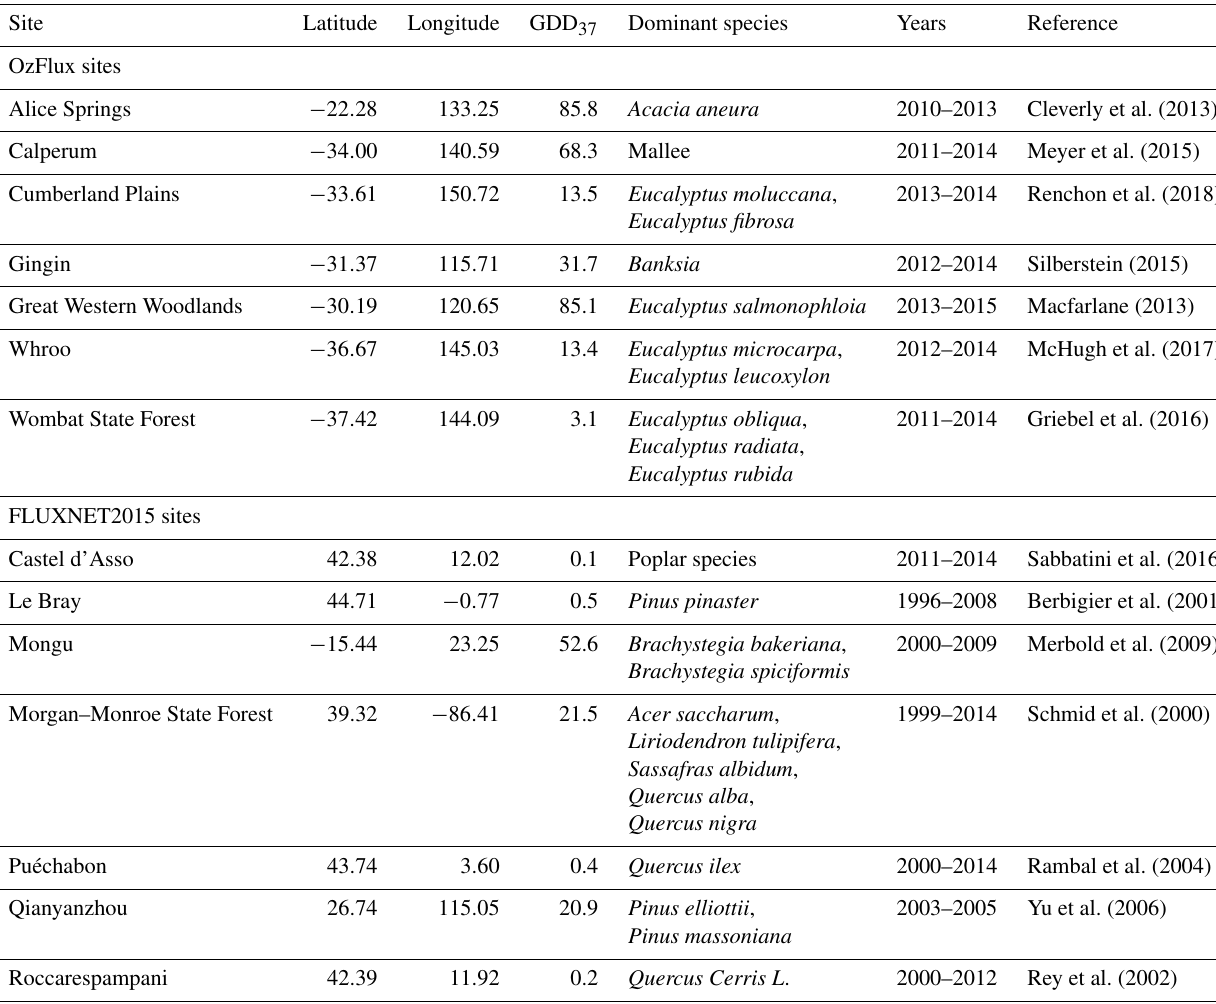
Table 1. OzFlux and FLUXNET2015 site information. GDD 37 is the average number of growing degree days above our threshold of 37 ◦ C. Plant functional types (PFTs) were ENF (evergreen needleleaf forest), EBF (evergreen broadleaved forest) and DBF (deciduous